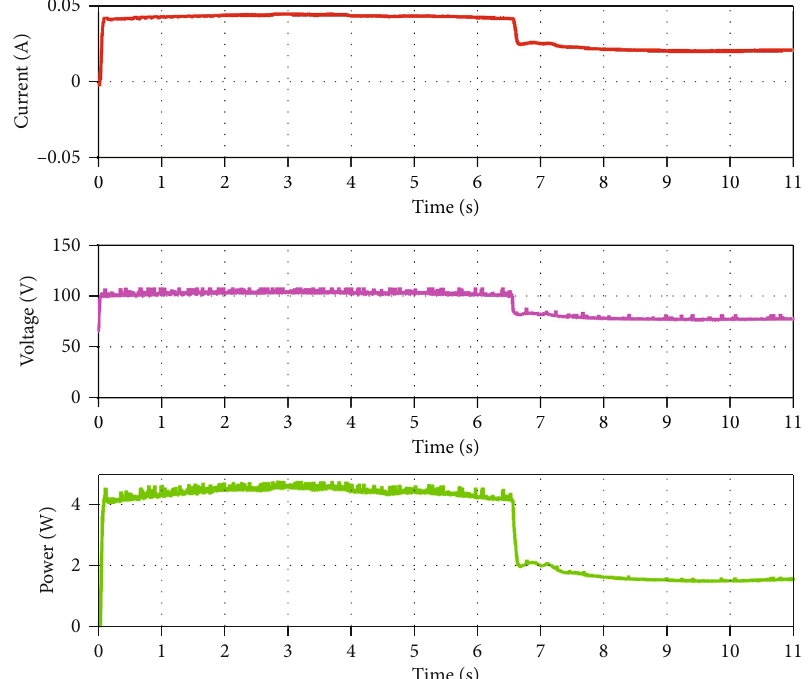
Figure 20: Experimental results of the proposed MPPT controller during a sudden energy